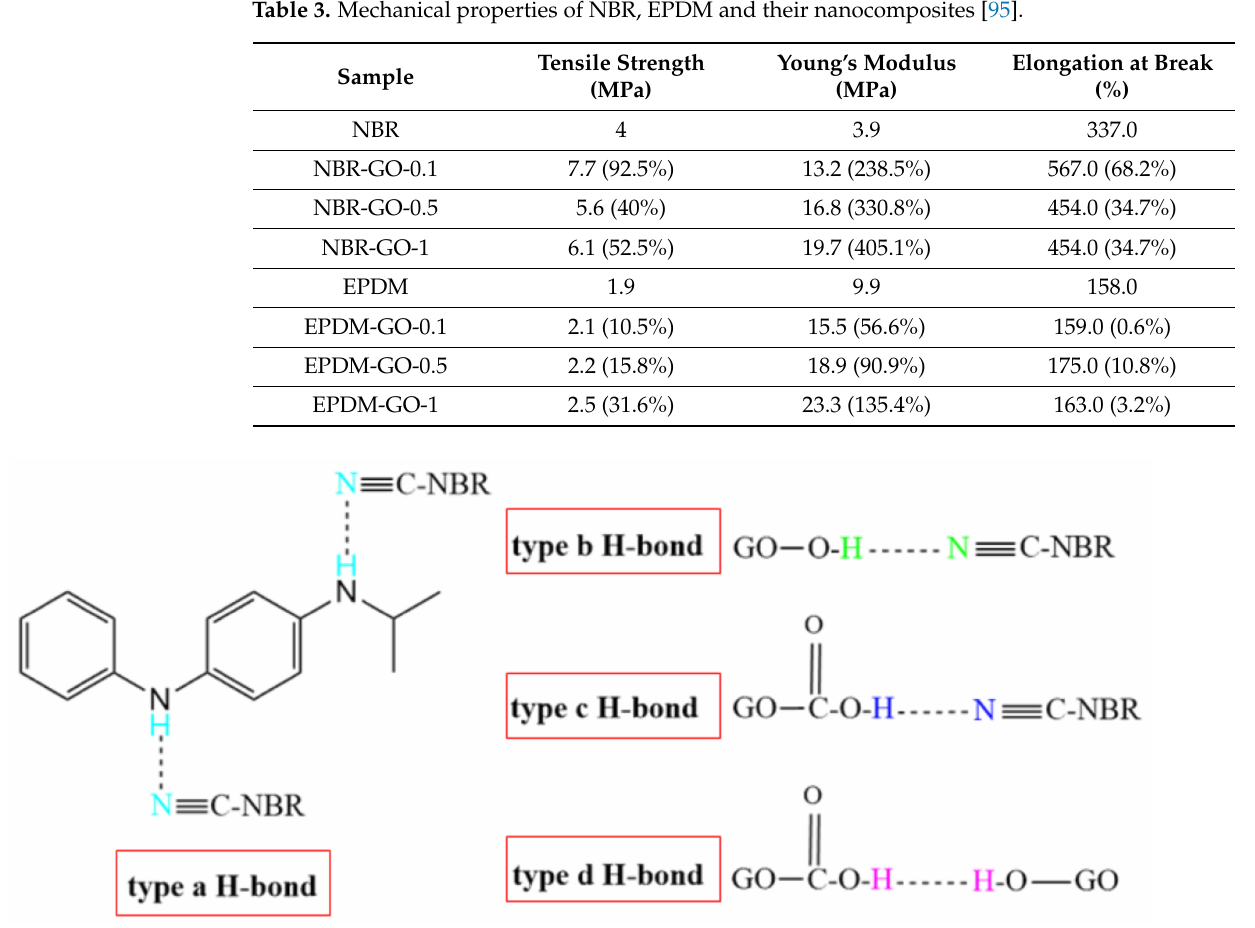
Figure 34. Four types of hydrogen bonds formed in NBR composites